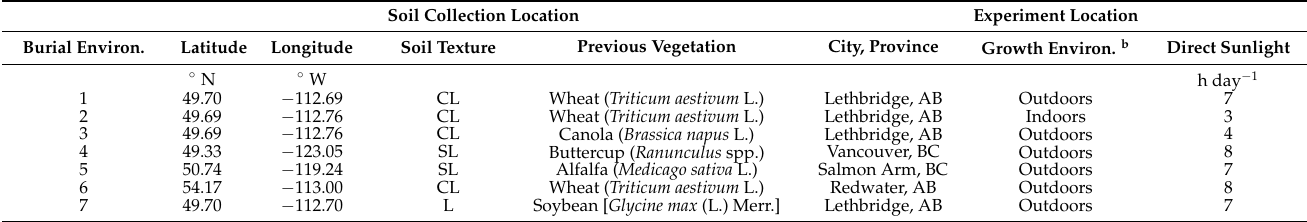
consisting of different soils and environmental conditions (Tables 1 and 2). The three factors were crop species (3), weed seed species (3), and burial environment (7). Within each burial environment, the main plot factor consisted of crop species (wheat, canola, and field pea), whereas the split plot factor consisted of weed seed species (kochia, wild oat, and volunteer canola). Table 1. Description and location of soil collection and seed burial for each repetition of a 7 week bioassay assessing the impact of crop species on seed mortality of kochia, wild oat, and volunteer canola a . Soil Collection Location Experiment Location Burial Environ.